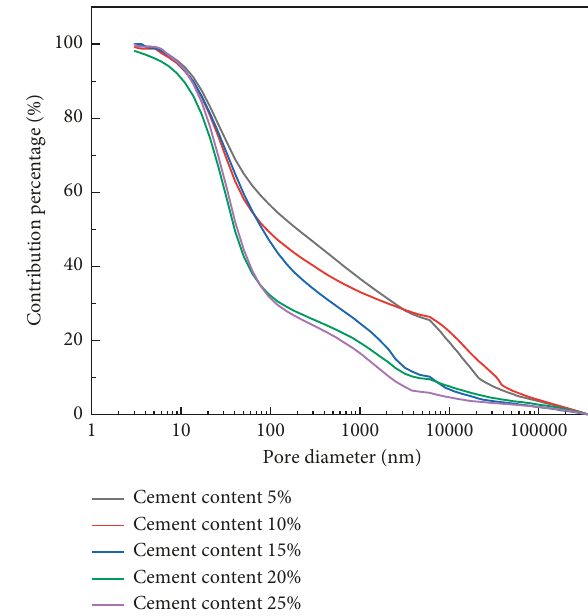
Figure 12: Cumulative curve of pore size of cement soil samples with different cement